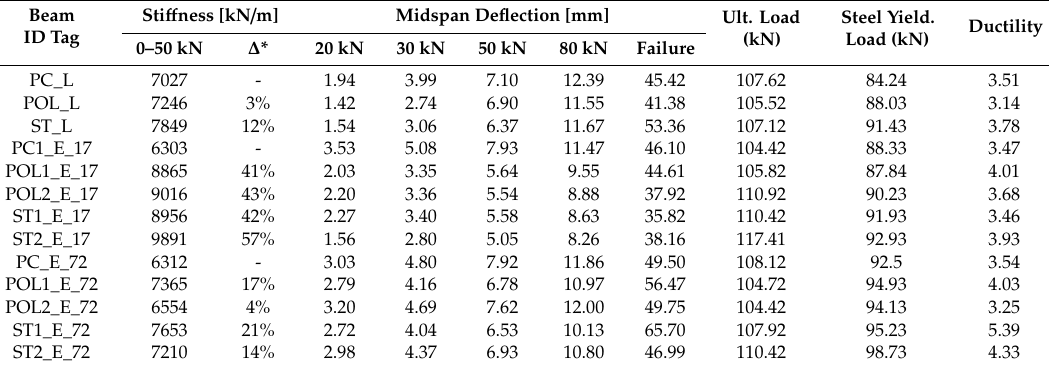
Table 3. Analysis of mechanical performance for the 72-month exposed beams in the four-point bending